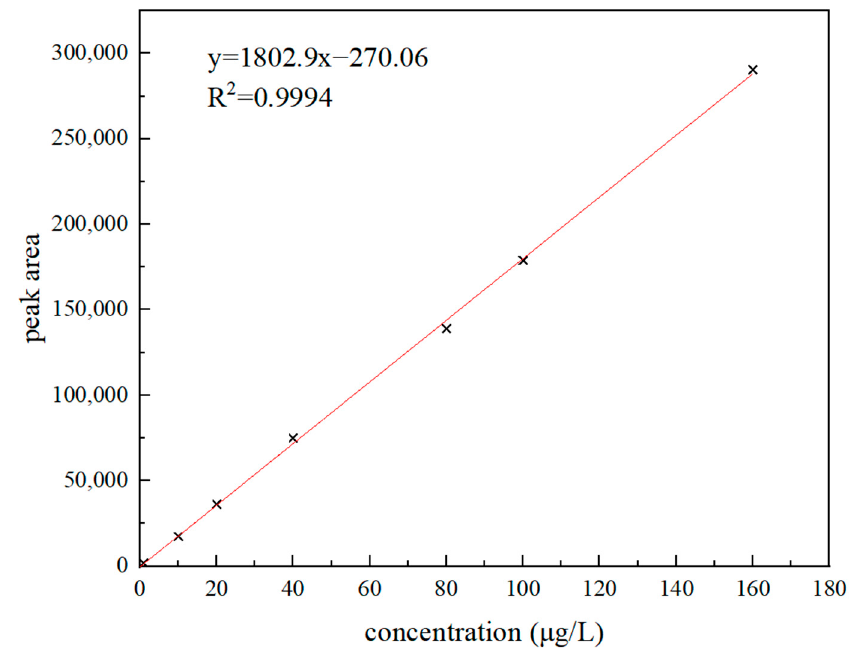
Figure 4. 3’-sialyllactose concentration and peak area curve. Figure 4. 3 (cid:48) -sialyllactose concentration and peak area curve.